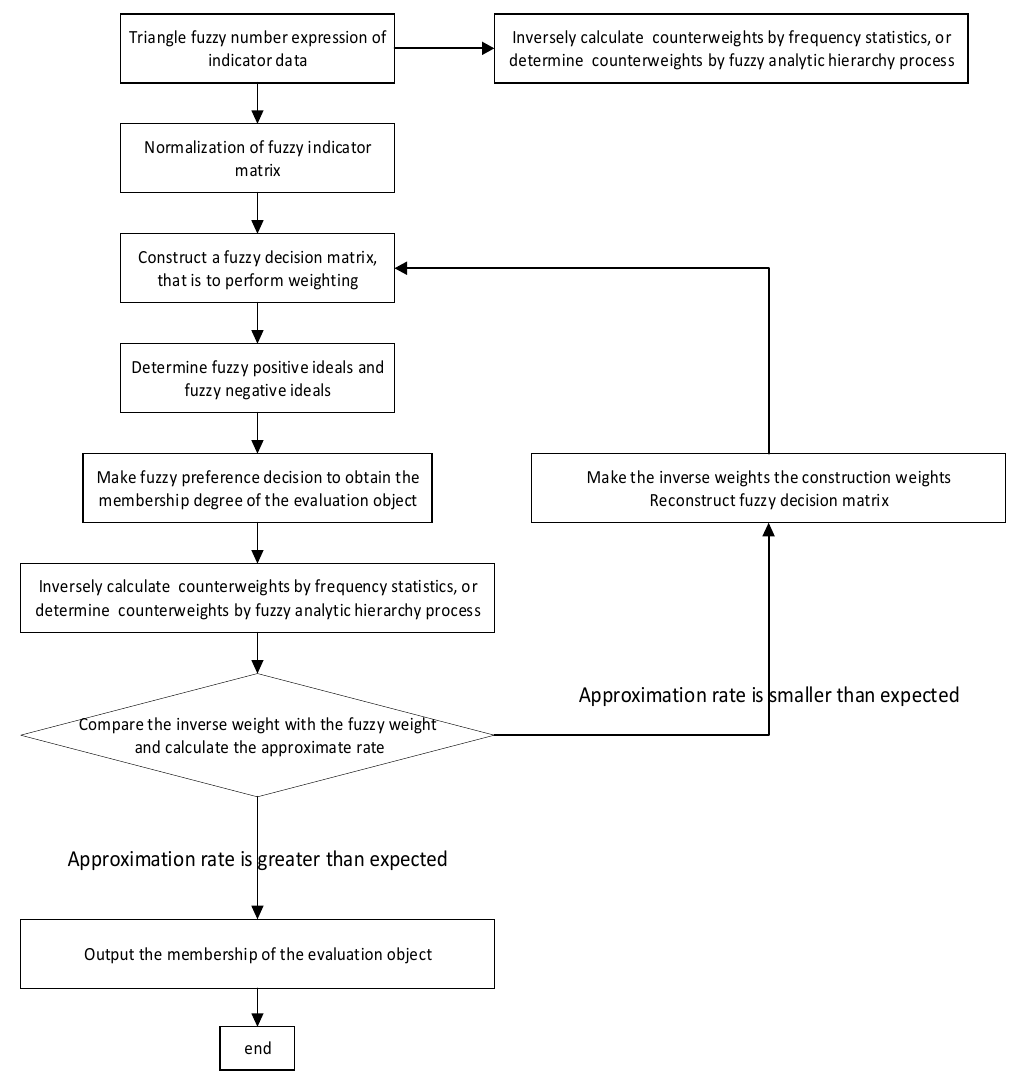
Figure 1. A flow chart of eclectic fuzzy decision-making model.